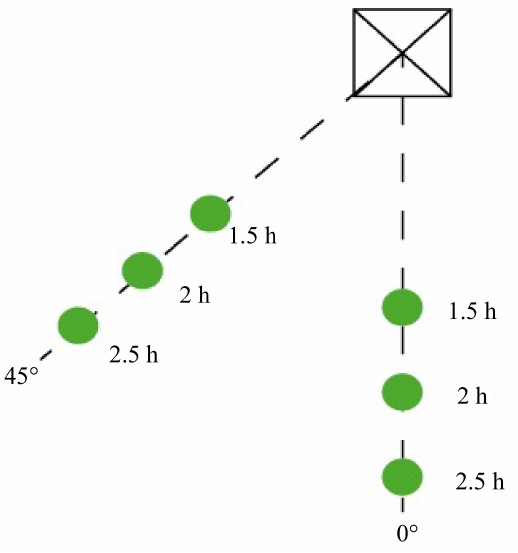
Figure 6. Positions selected for taking